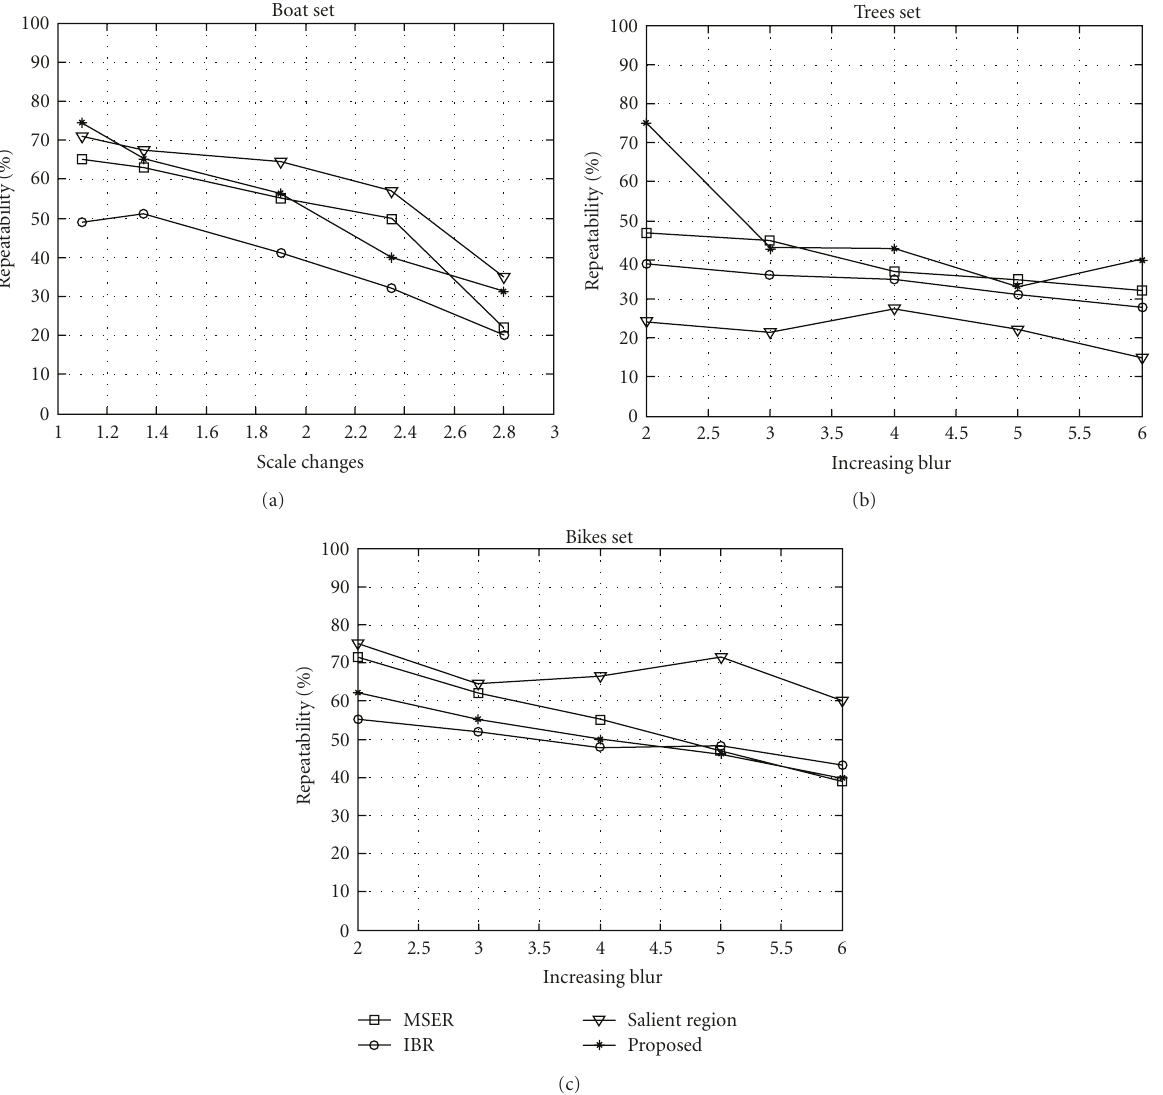
Figure 10: Repeatability scores for BOAT, TREES, and BIKES sequences (see Figure 9